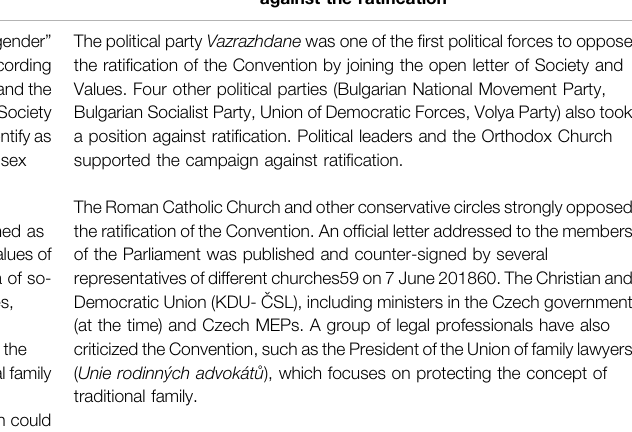
Arguments against rati fi cation